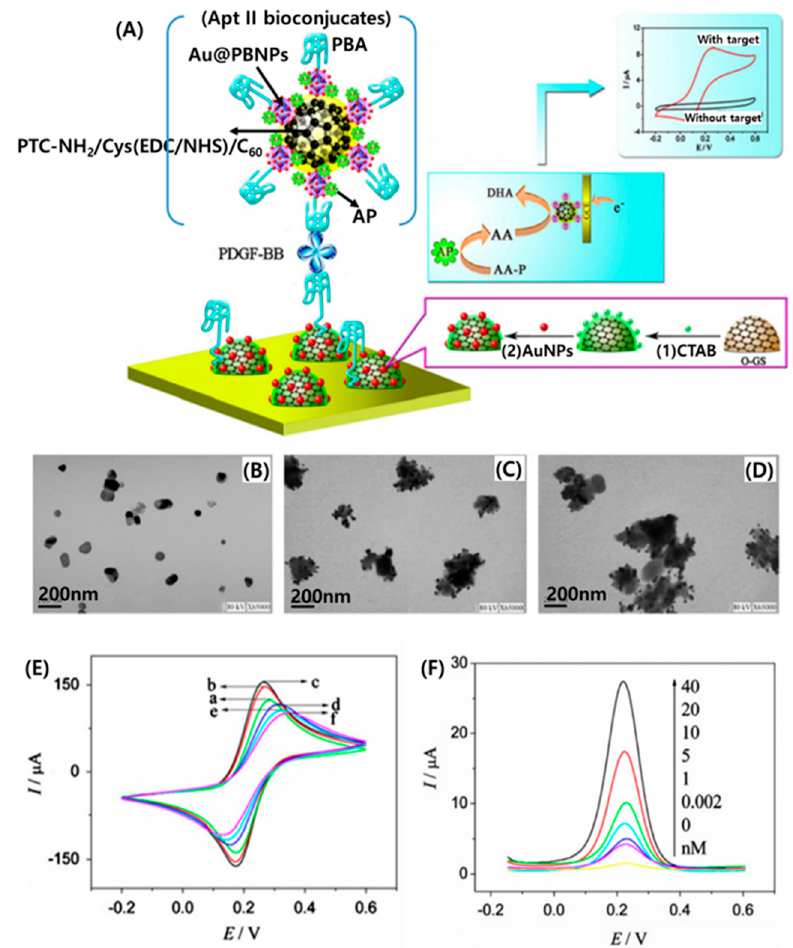
Figure 14. ( A ) Schematic illustration of the stepwise aptasensor fabrication process and the dual signal amplification mechanism. TEM images of ( B ) FC 60 NPs, ( C ) Au@PBNPs, and ( D ) Au@PB / FC 60 . ( E ) Cyclic voltammograms (CVs) of di ff erent electrodes in 5.0 mM Fe(CN) 6 3 − / 4 − solution containing 0.1 M KCl at a scan rate of 50 mV / s: (a) bare GCE, (b) O-GS / GCE, (c) AuNPs / O-GS / GCE, (d) Apt I / AuNPs / O-GS / GCE, (e) HT / Apt I / AuNPs / O-GS / GCE, (f) after incubation with 10 nM PDGF. ( F ) DPV responses of the proposed immunosensor after incubation with di ff erent concentration of PDGF. Reproduced with permission from [122], Copyright @ 2013 Elsevier